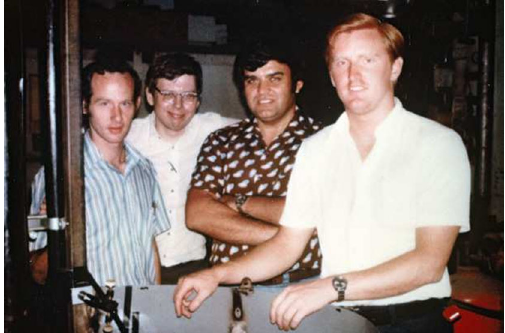
FIG 6. Team photograph taken the evening the oscillator experiment first crossed threshold. From left to right: